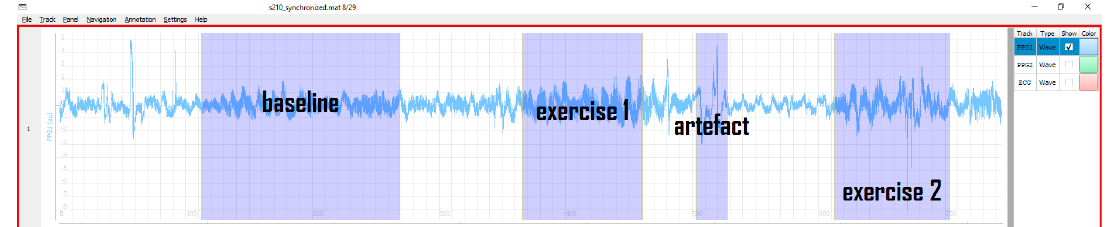
Figure 4. Example PPG signal in partition mode: one can label activities, motion artefacts, and other regions of interest.